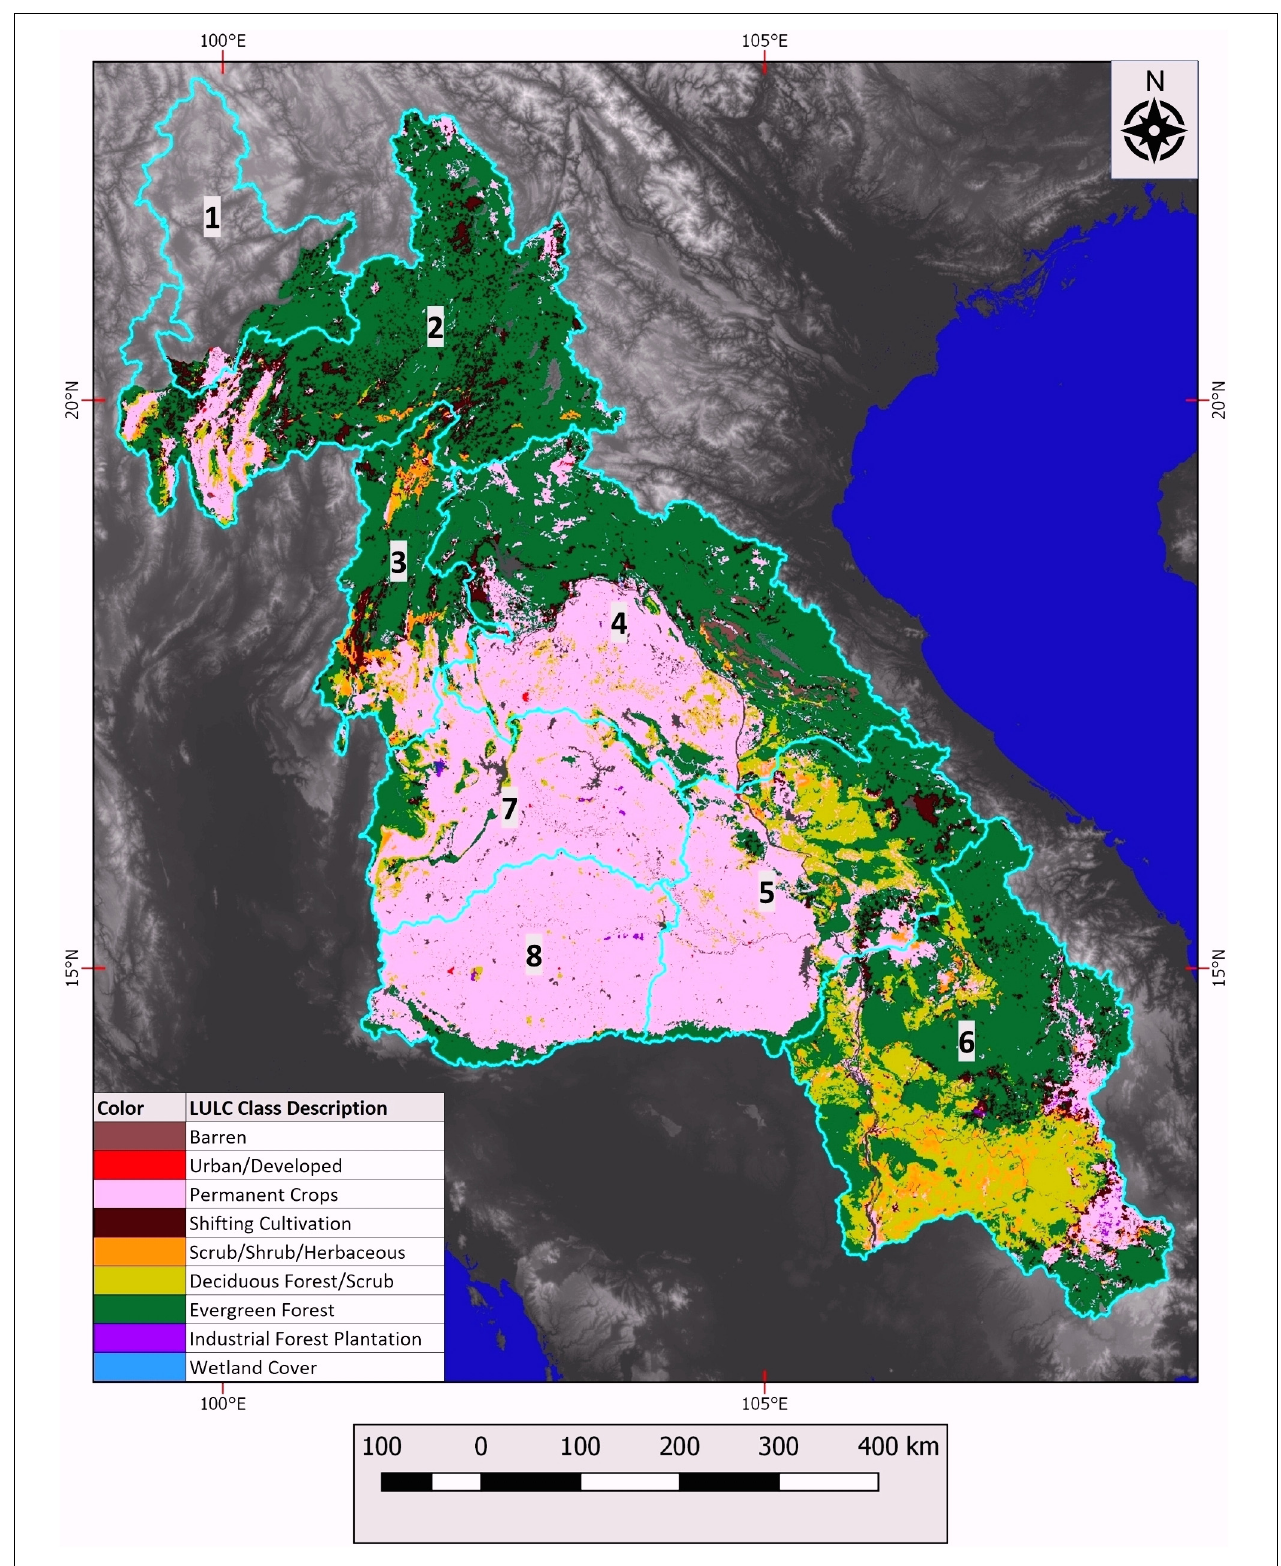
FIGURE 2 | Study area 1997 LULC map with SB boundaries overlain in cyan for SBs 1–8. The SB #s are included as black text. The backdrop image adjacent to the LULC map is a 90 m DEM from SRTM data.